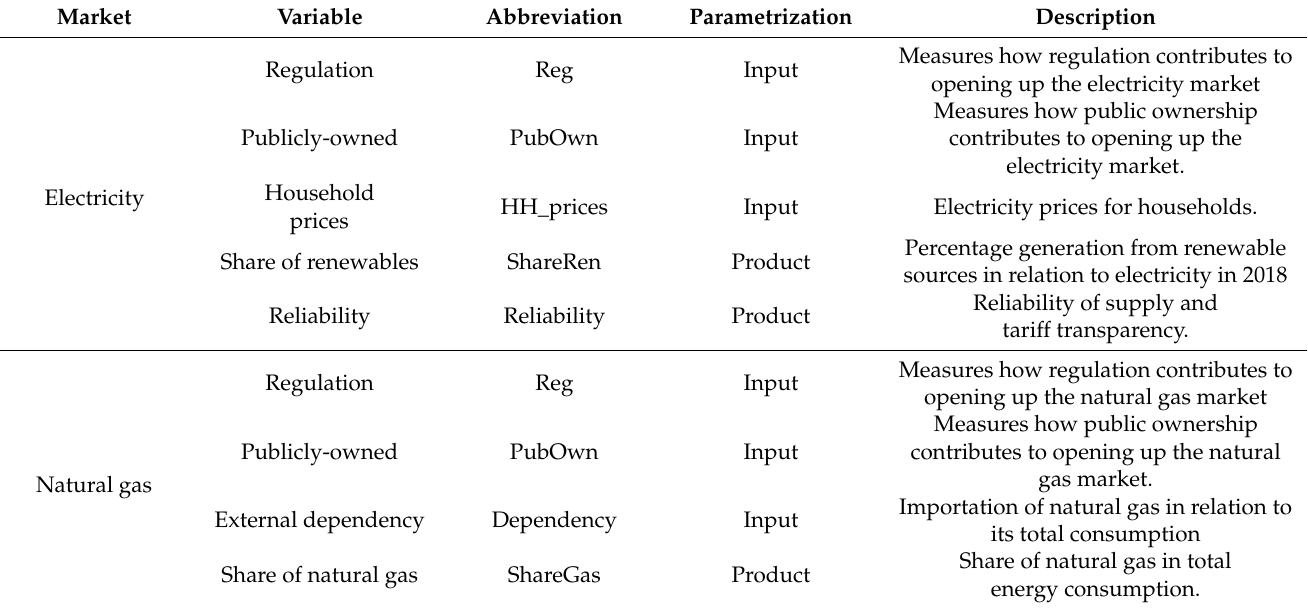
Table 4. Qualitative description of the variables. Source: Drawn up by the authors, based on [9,23].